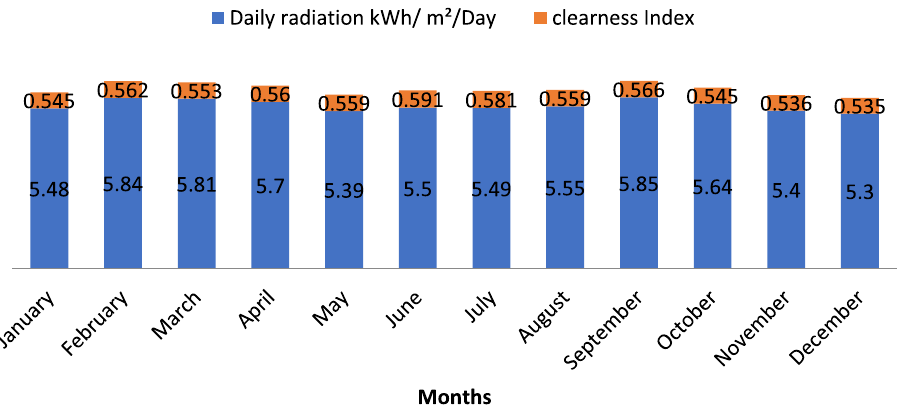
Figure 2. Annual average solar radiation and clearness index